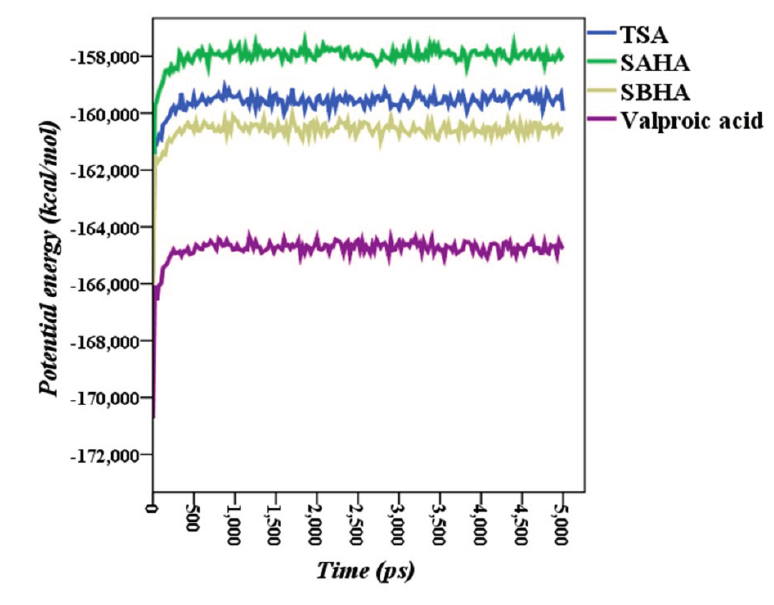
Figure 9. Potential energies (kcal·mol − 1 ) of Plasmodium falciparum histone deacetylase1 ligand complexes during molecular dynamics